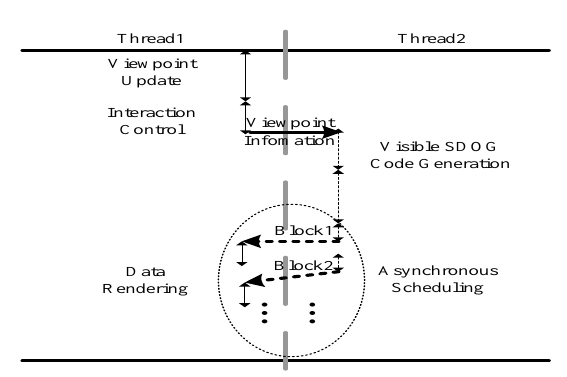
Figure 9. Mechanism of multi-thread data scheduling